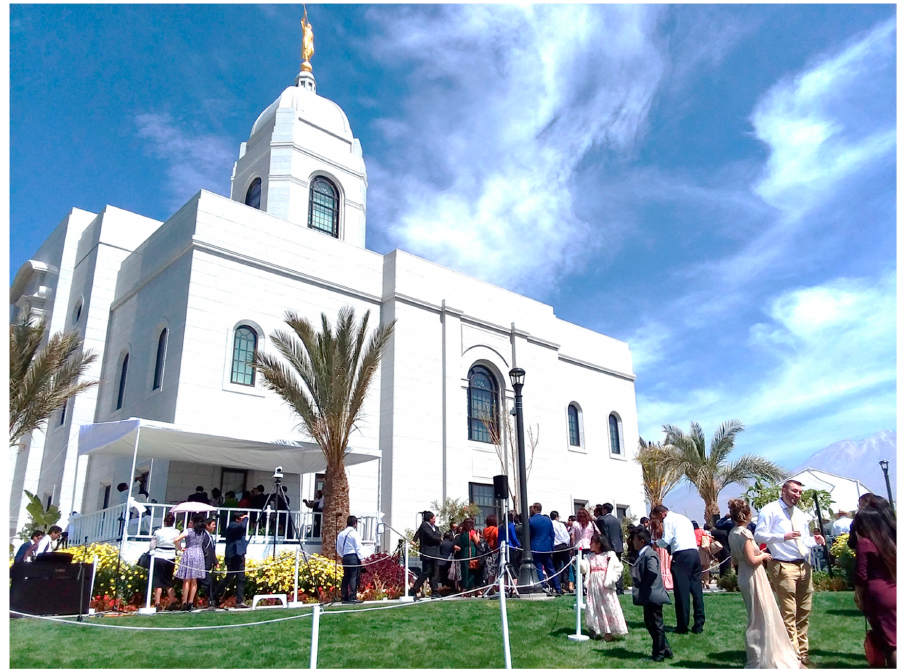
Figure 3. The Arequipa temple on the day of its dedication. Notice the golden statue. December 2018. This is why the vampire of the Andes, the kharisiri , is so insidious. It does not take the time to solidify the substance of Andean personhood into the material form of money before it removes it from the cyclical system. Instead, it sucks that personhood, in the form of body fat, directly from its victims. As a recent Mormon convert from Puno, Peru, who knows a thing or two about the kharisiri from personal experience once told me, you might be sitting on the bus next to a rich, white businessman in a suit and tie [not that dissimilar from an Anglo Mormon missionary] who is really the kharisiri in disguise. Without you noticing, as he sits next to you, he will stick you in the side with an extremely fine needle that you cannot feel, suck your body fat into a syringe, and sell your substance—rich in collagen and lipids—to cosmetic companies in the US. Along with your body fat, the kharisiri extracts your personhood. If you cannot get to a skilled shaman in time, you will “dry up” and die within a matter of days. In one of the few anthropological studies on Mormonism in South America, Cesar Ceriani Cernadas (2008) wrote of syncretic rumors in Argentina’s Chaco designed by anti- Mormons to combine local toba fears with Mormon doctrine. As a result of the rumors, legend has it in the Chaco that Joseph Smith, the founder of Mormonism, was himself a